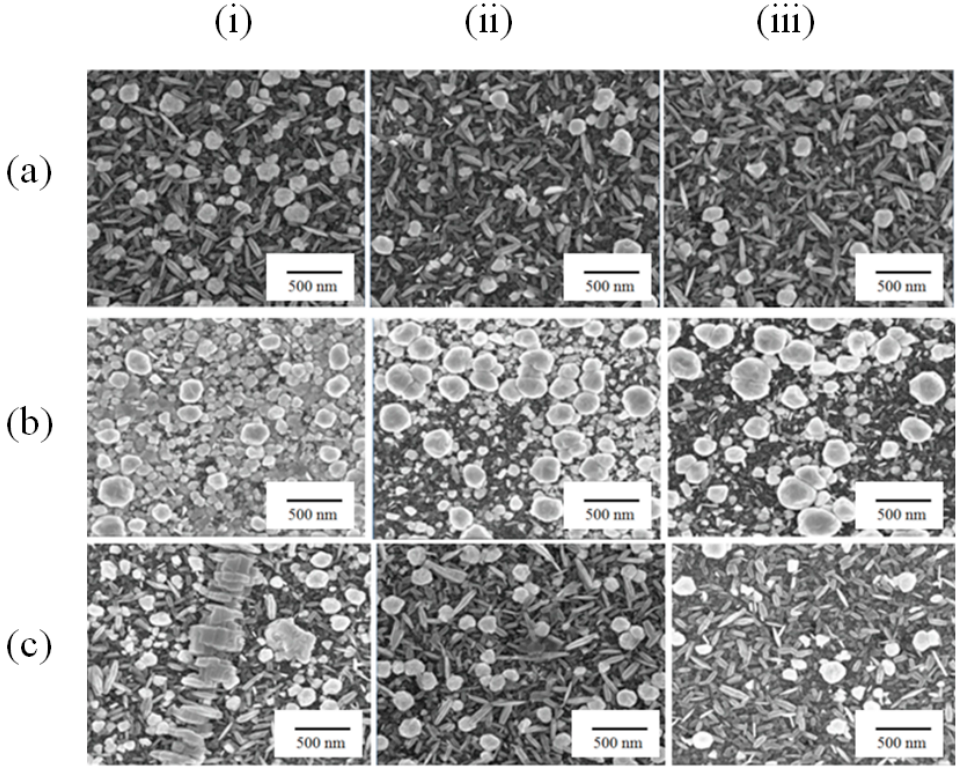
Figure 3. SEM images of surface treatment of Au nanostructures with chitosan coating. Chitosan of ( a ) 1000 Da ( b ) 1000–3000 Da and ( c ) 5000 Da coated Au nanostructures ( i ) only immersion for 30 min ( ii ) immersion with shaking for 15 min and ( iii ) immersion with shaking for 30 min.